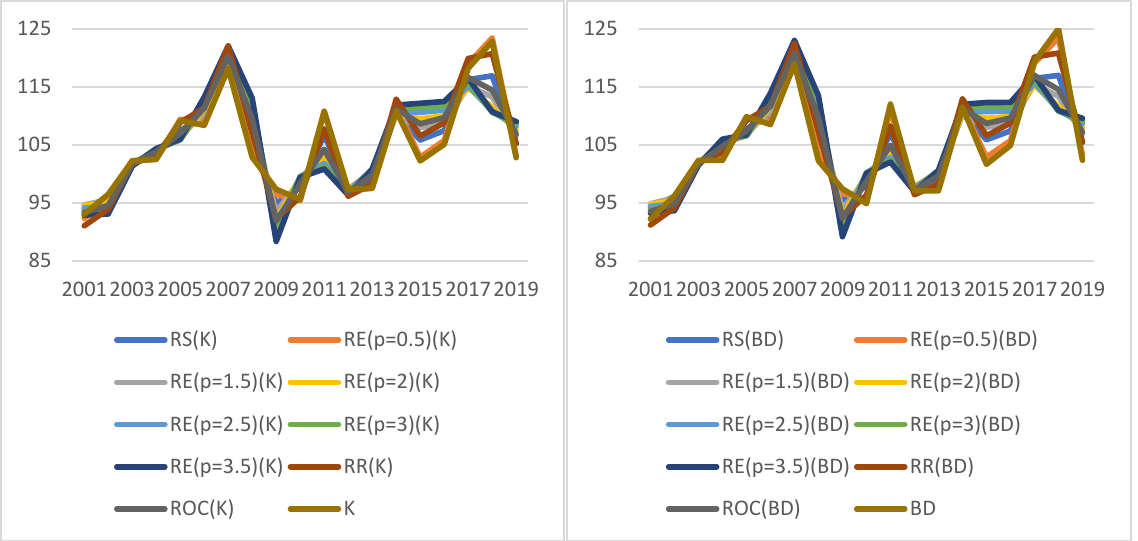
𝐸 ). Source: a uthors’ own material based on ). Source: authors’ own material based on 0 t , t 0